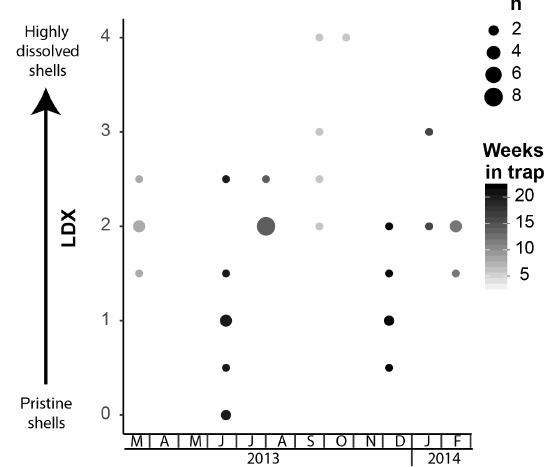
Figure 5. Shell condition of Heliconoides inflatus , ranked using the Limacina Dissolution Index (LDX) scale, over the study period. The samples with the poorest preservation are from September and Oc- tober 2013, when water temperatures were the highest. The size of the circles corresponds to n , the number of specimens plotted at a given point, and the color of the circles corresponds to the maxi- mum number of weeks specimens were in the